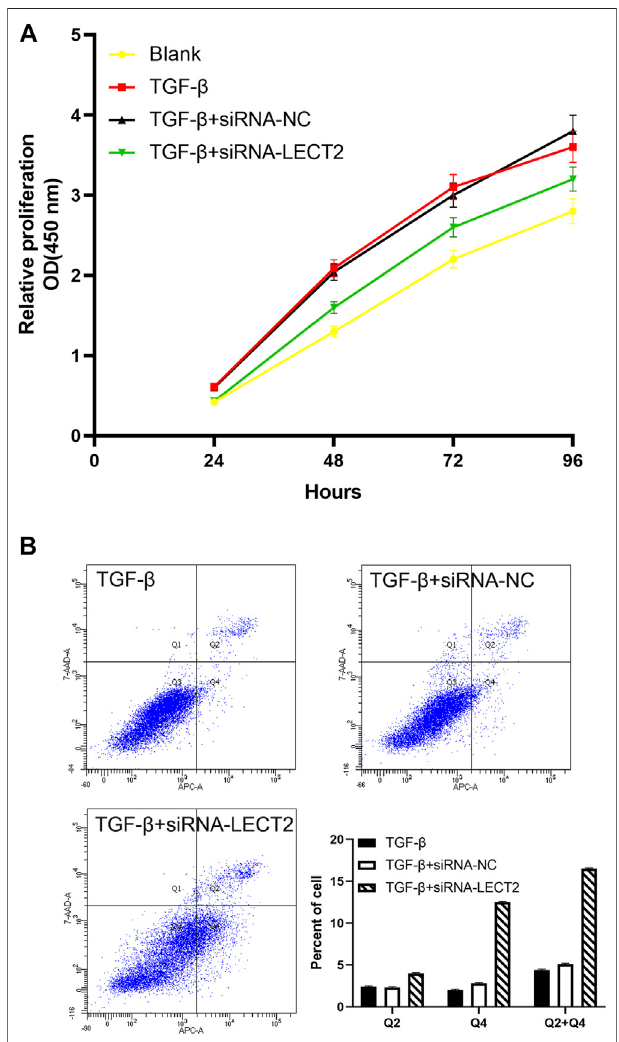
FIGURE 6| The effect ofLECT2 on LX2 cells proliferation and apoptosis (A) Knockdown of LECT2 inhibits the proliferation in activated LX-2 cells (B) Knockdown of LECT2 increase apoptosis in activated LX-2